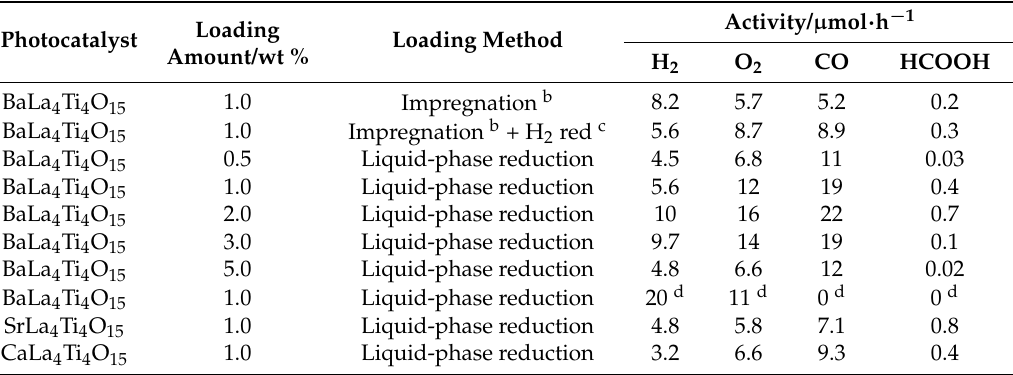
Table 5. Effect of loading method of Ag co-catalyst on the photocatalytic activity for CO 2 reduction over ALa 4 Ti 4 O 15 (A = Ca, Sr, and Ba) a